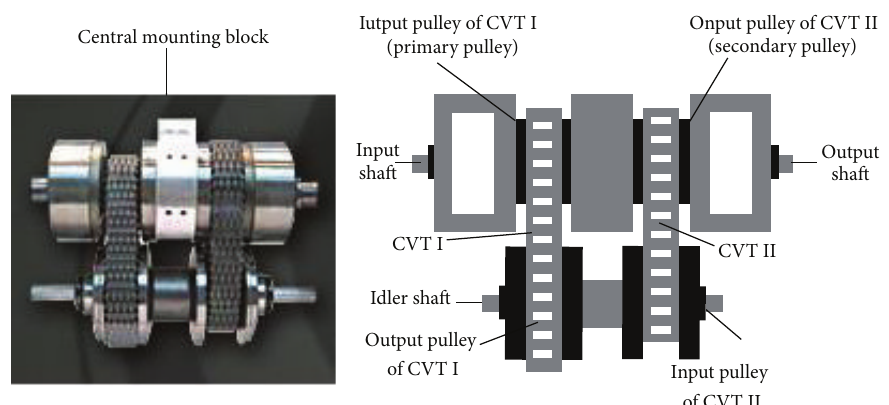
Figure 2: Inline chain CVT